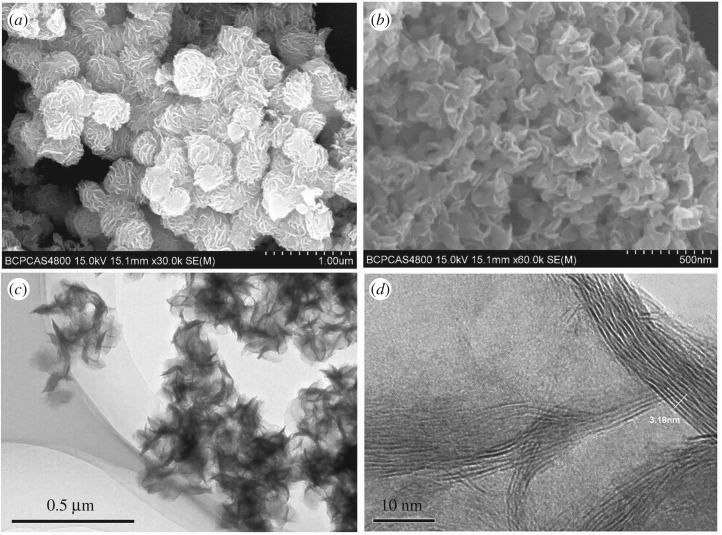
The SEM (a,b) and TEM (c,d) images of the PEG@MoS2 composites.